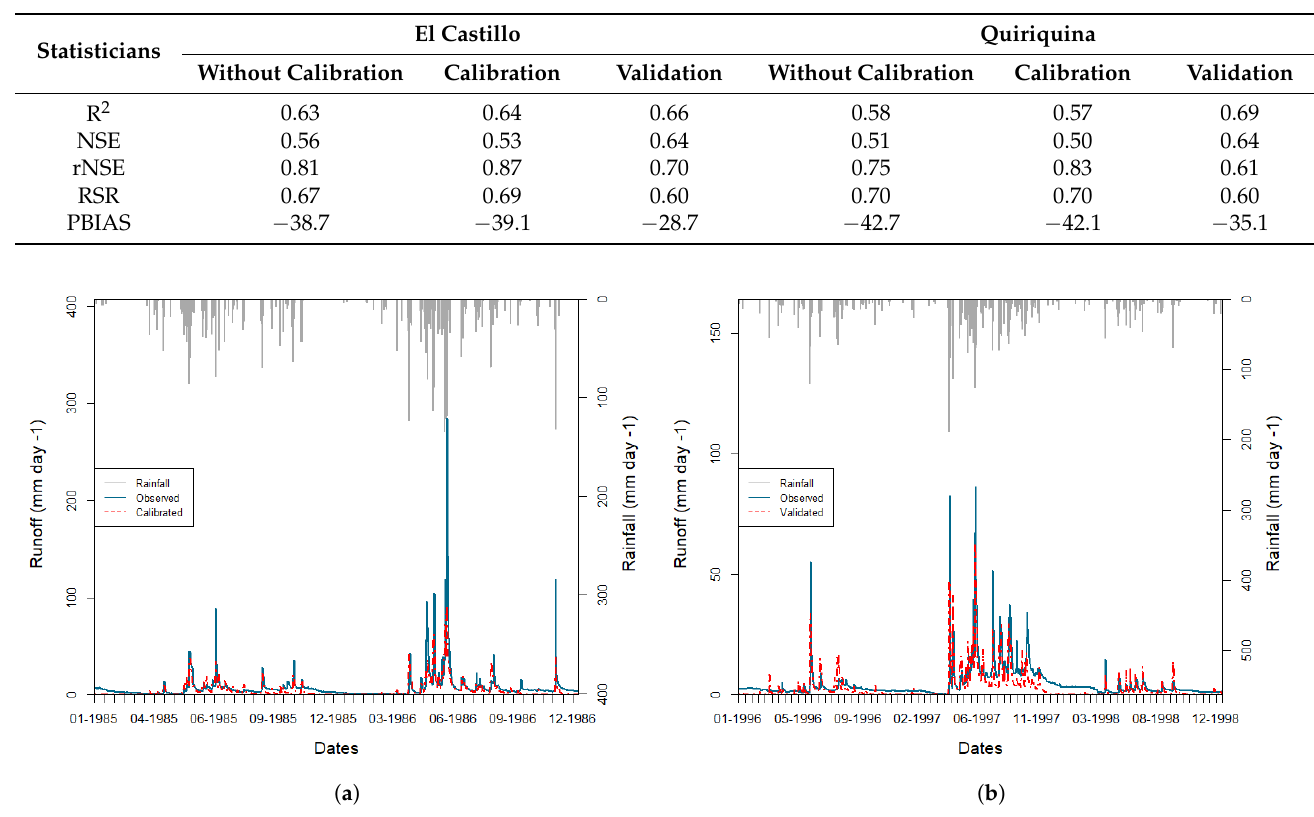
Figure 4. Calibration ( a ) and validation ( b ) period at daily time step for El Castillo and Quiriquina stations,